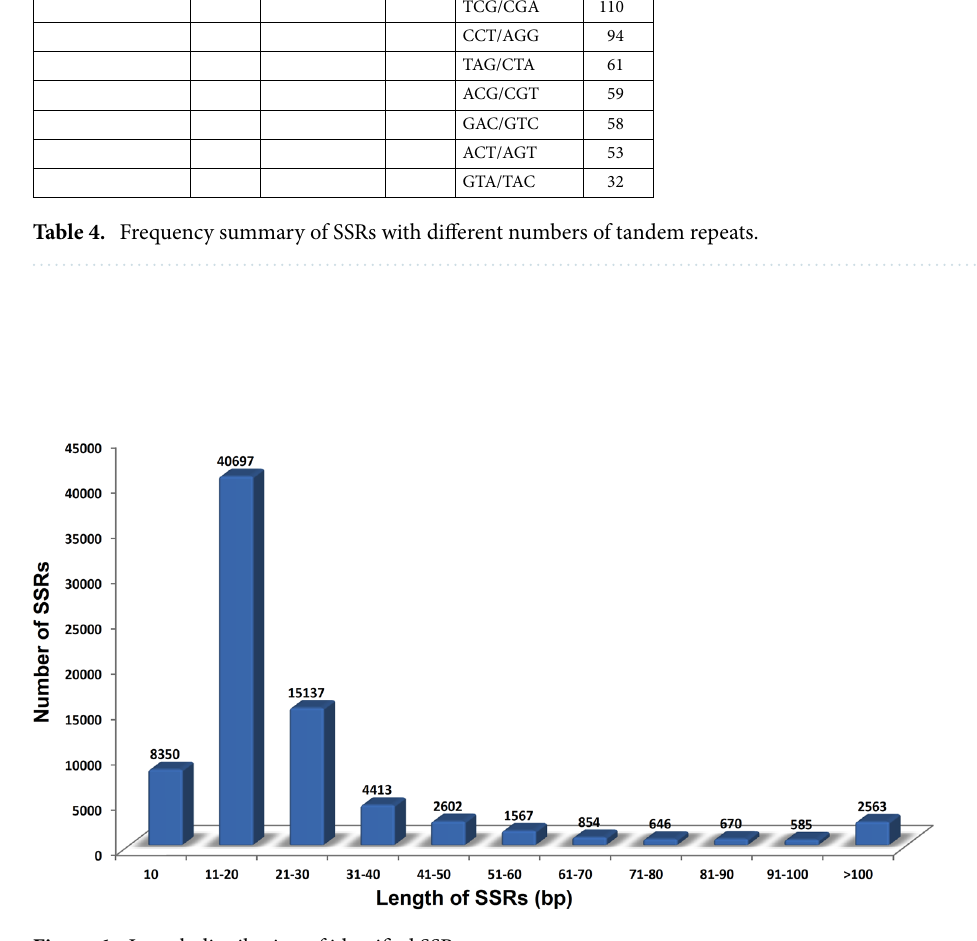
Figure 6. Length distribution of identified